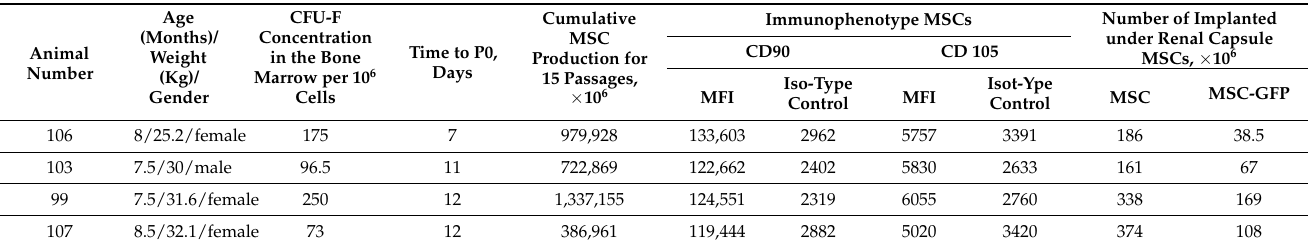
Table 1. Characteristics of mini pigs, CFU- F and